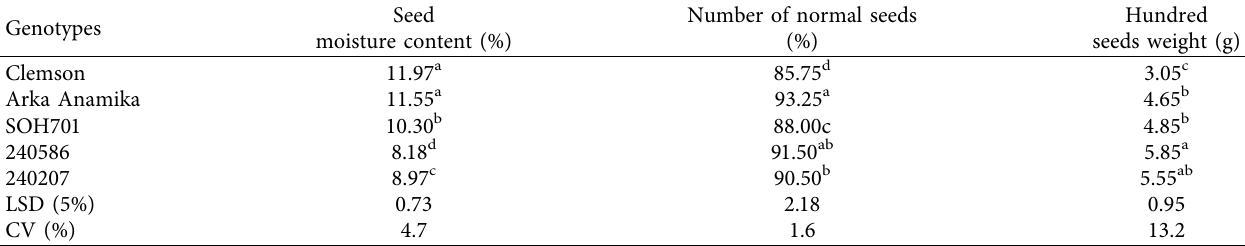
Table 2: Efect of okra genotypes on seed moisture content, number of normal seed, and seed weight.